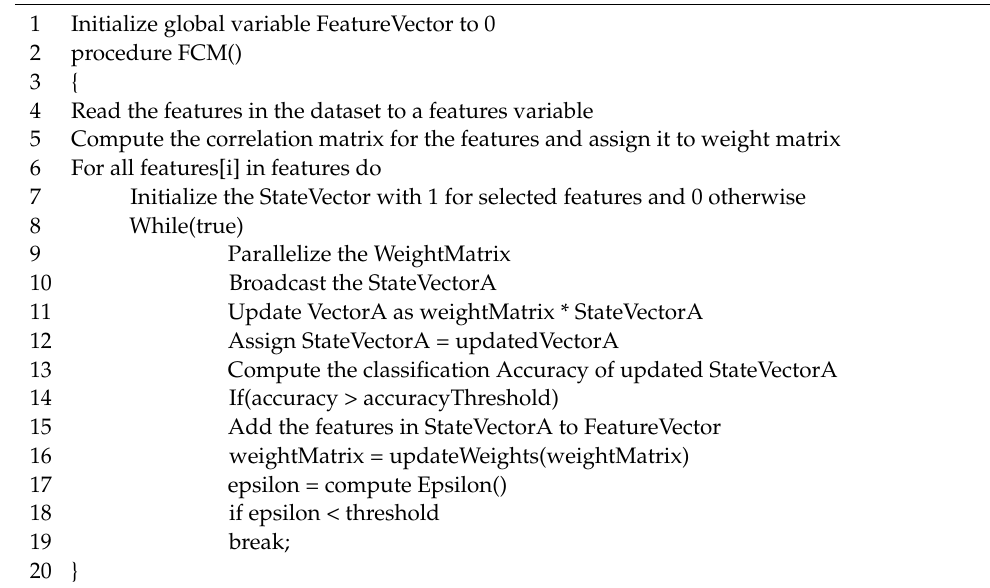
Algorithm 1. Distributed Fuzzy Cognitive Map (FCM) algorithm for feature selection in big